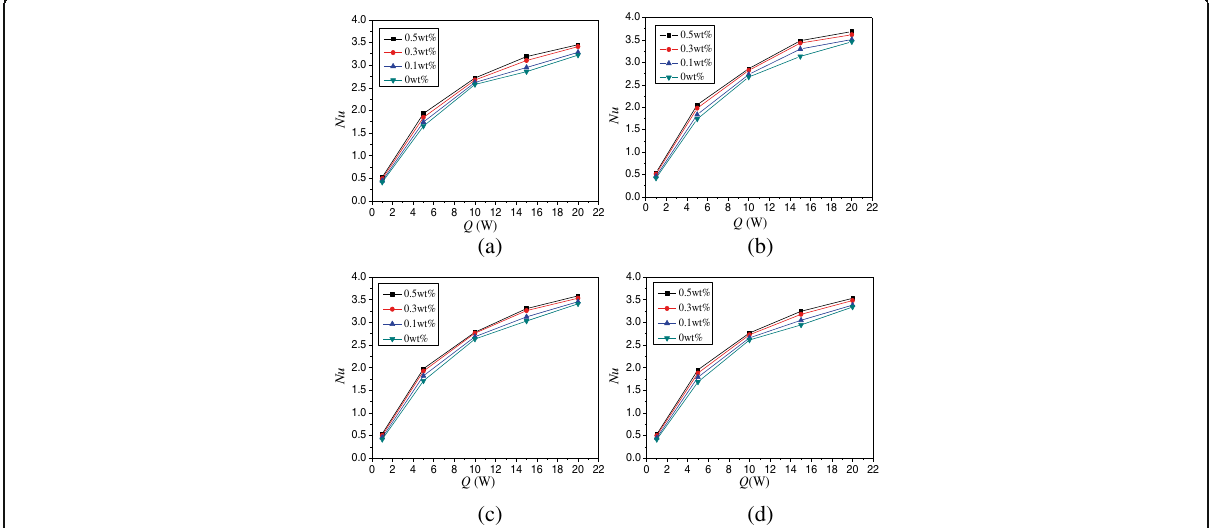
Fig. 10 Changes of Nusselt numbers with heating power ( A = 1:2). Average Nusselt numbers changes of nanofluid in the enclosure ( A = 1:2) with heating power at different rotation angles. a α = − 45°. b α = 0°. c α = 45°. d α =